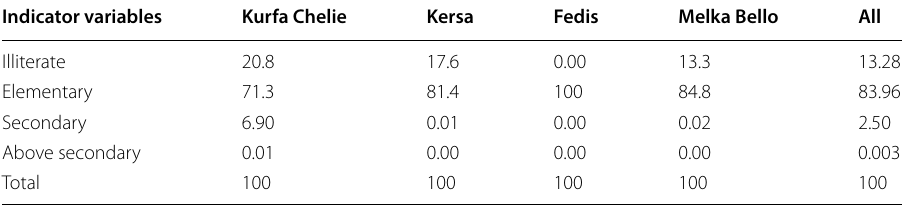
Table 1 Education background of the sampled households. Source: Own Survey, 2015 Indicator variables Kurfa Chelie Kersa Fedis Melka Bello All Illiterate 20.8 17.6 0.00 13.3 13.28 Elementary 71.3 81.4 100 84.8 83.96 Secondary 6.90 0.01 0.00 0.02 2.50 Above secondary 0.01 0.00 0.00 0.00 0.003 Total 100 100 100 100 The values in the table are percentage